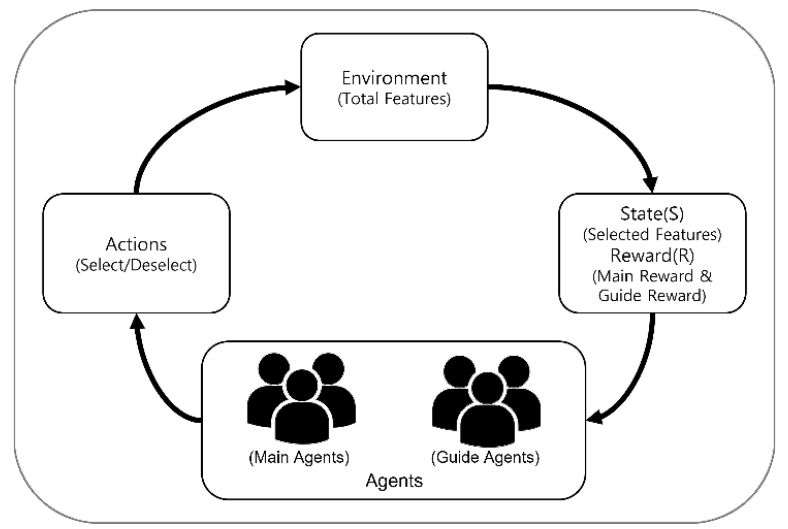
Figure 1. Illustration of Multi-Agent Reinforcement Learning Feature Selection Method with Guide Agents